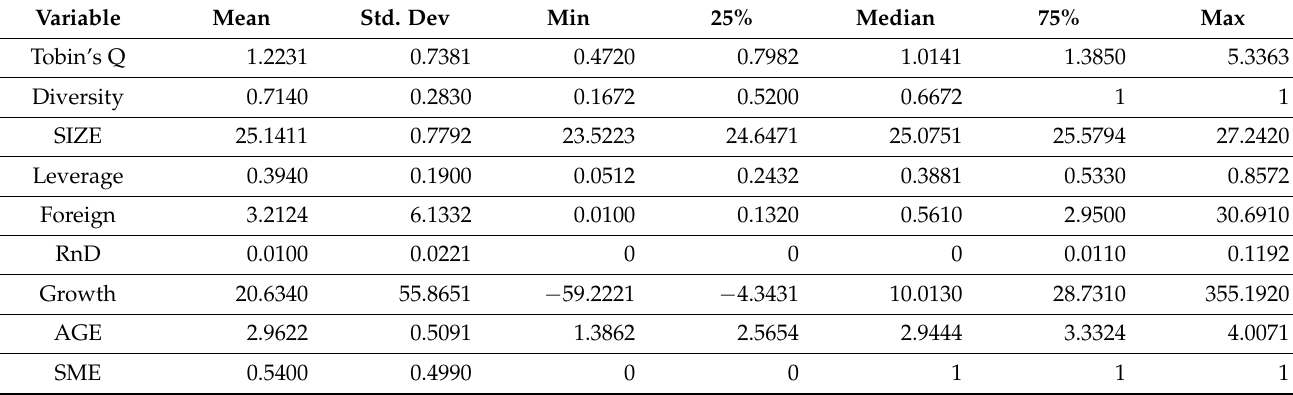
Table 1. Descriptive Statistics (N =